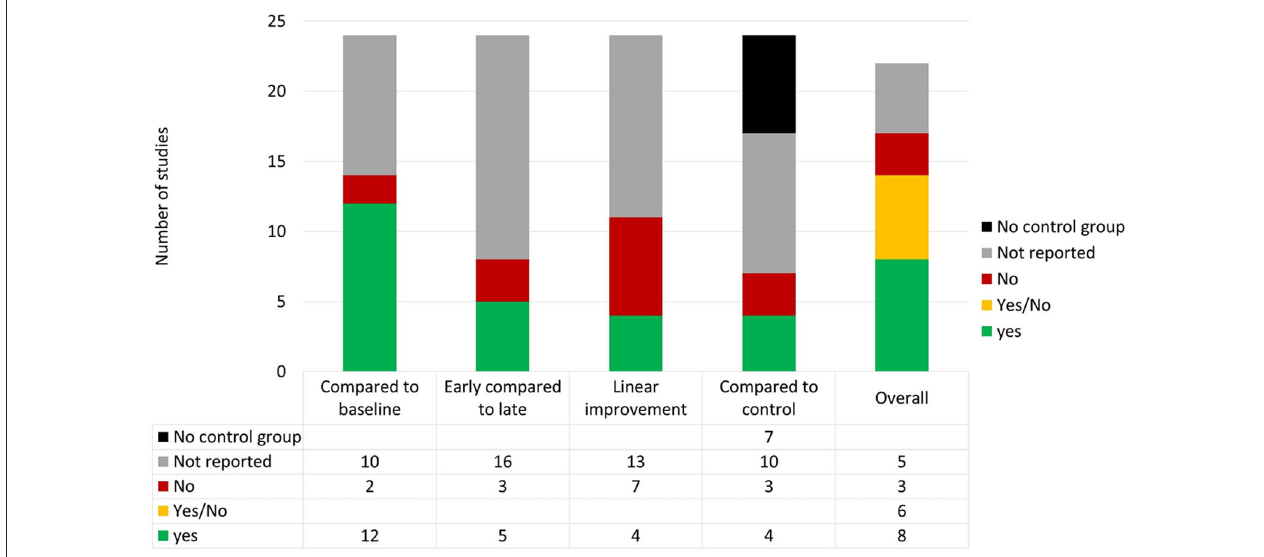
FIGURE 6 | Neurofeedback regulation success. Overall regulation was classified “Yes” if a significant effect for one or more of the four measures were reported and “No” if no significant effect was reported. If both were reported, the overall regulation was classified “Yes/No.” Note that Kober et al. (2015, 2018) trained the regulation of HbO and HbR in different groups and found differential results for the groups. Therefore, the two studies were counted twice for the four measures. In overall regulation, the two studies were only counted once and were classified as “Yes/No”.